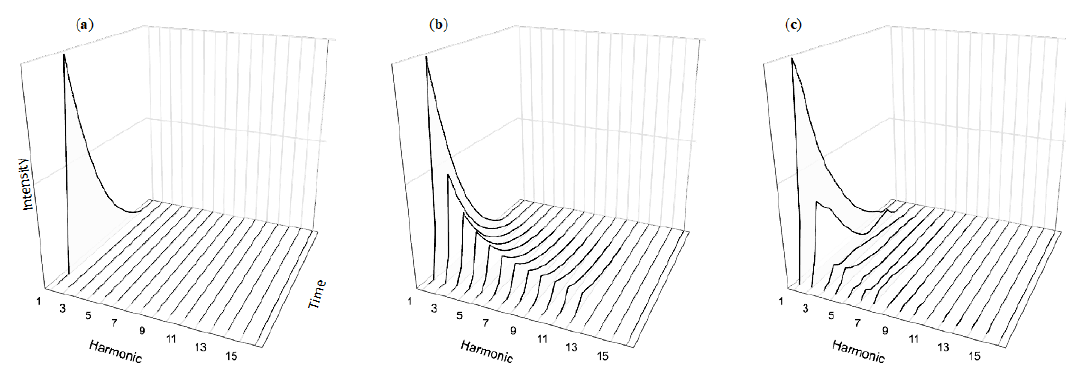
Figure 4. A harmonically simplistic decaying tone, also called a percussive tone ( a ) as well as a harmonically rich percussive sawtooth tone ( b ) and a single piano note ( c ).